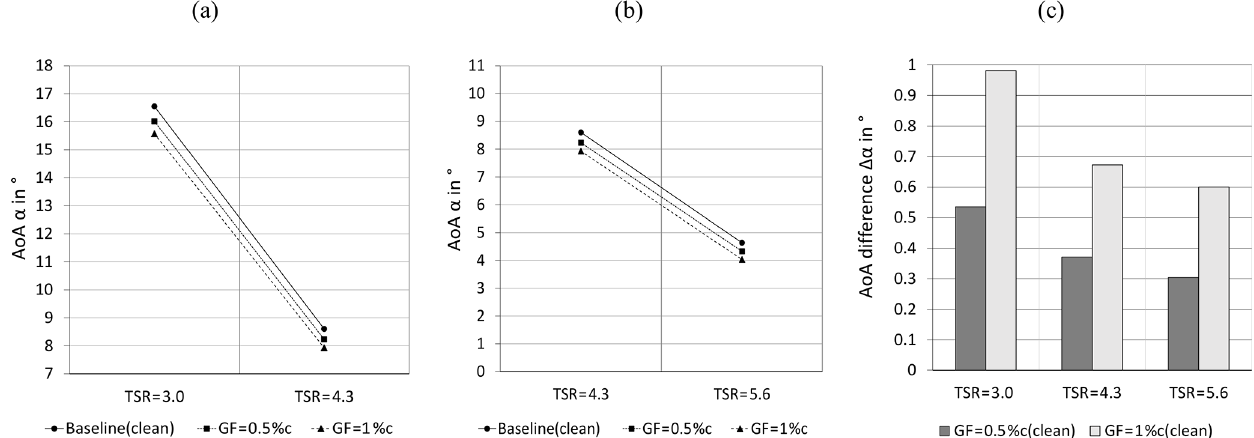
Figure A2. Angles of attack in the clean case at r = 0.56 R and ϕ = 270 ◦ . (a) Stall and rated conditions. (b) Rated and feather condi- tions. (c) AoA difference between Gurney flap configuration and the